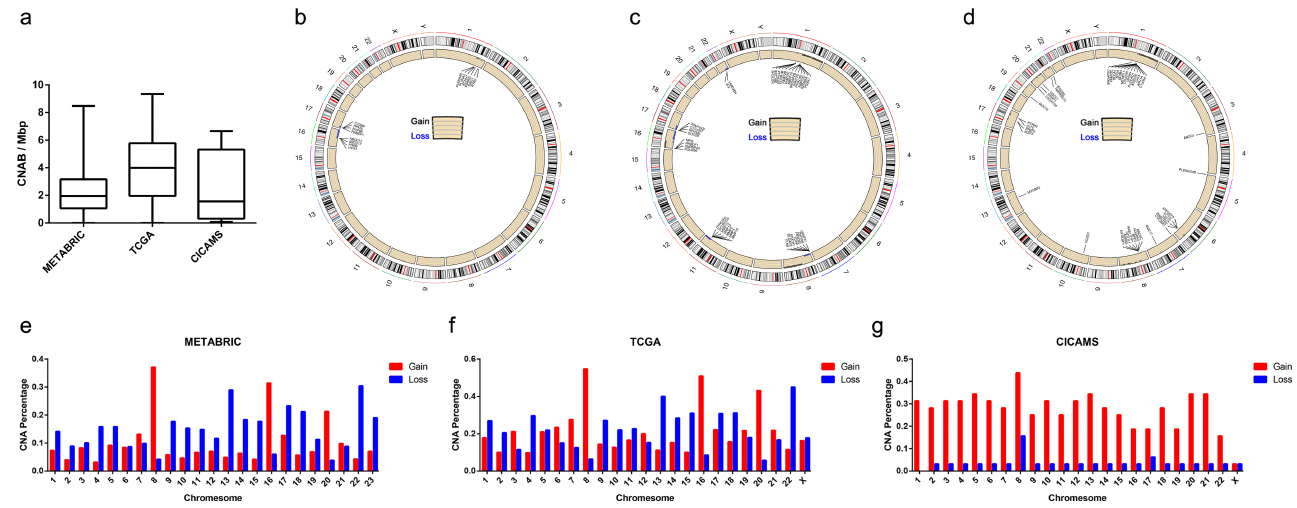
Figure 1. Copy number alteration of the study population. ( a ) Copy number alteration burden of three breast cancer cohorts; ( b – d ) the genes with more than 50% copy number alteration in patients from METABRIC, TCGA, and CICAMS; ( e – g ) the percentage of CNA per chromosome from METABRIC, TCGA, and